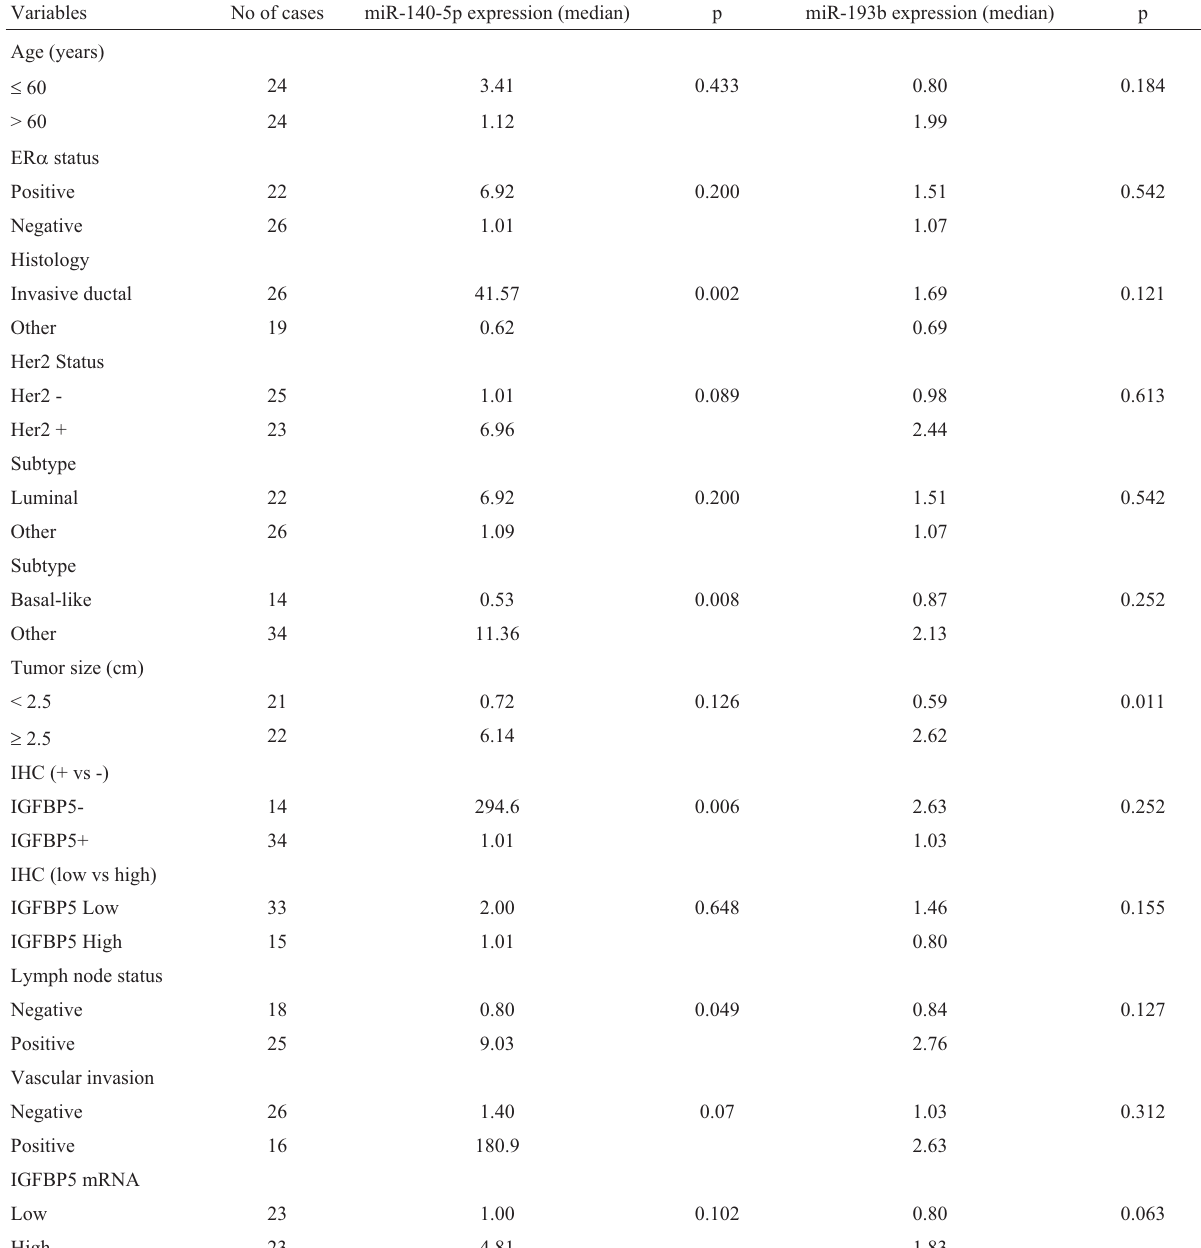
Table1 -miR-140-5pandmiR-193bexpressionininvasivebreastcarcinomasinrelationtoclinicopathologicalcharacteristicsandIGFBP5expression